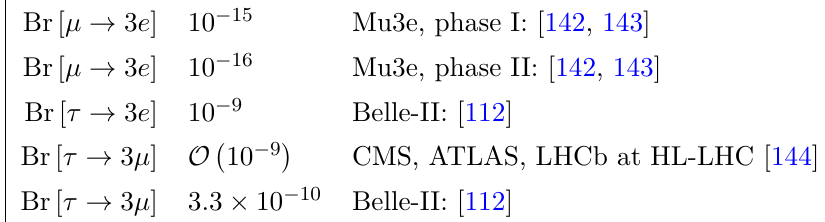
Table 9. Future sensitivities to Br( ‘ → 3 ‘ 0 )